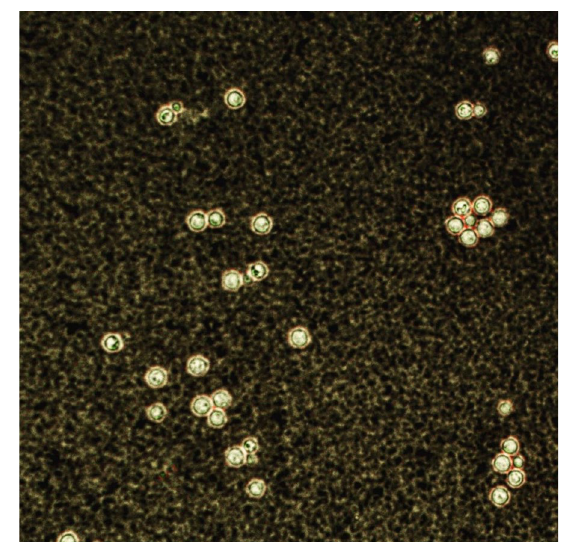
Fig. 3 India ink staining of C. neoformans showing encapsulated and budding yeast cells under phase-contrast microscope (magnification 100 ×